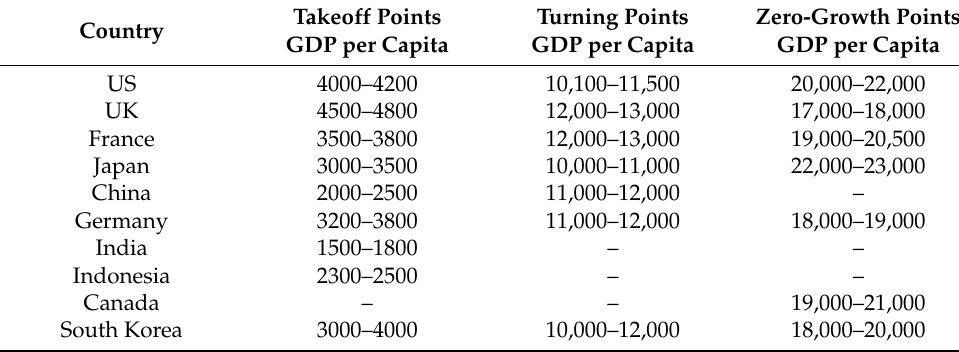
Table 2. Key points of expanded S-curve for each country (1990 GK in USD). Takeoff Points Turning Points Country GDP per Capita GDP per